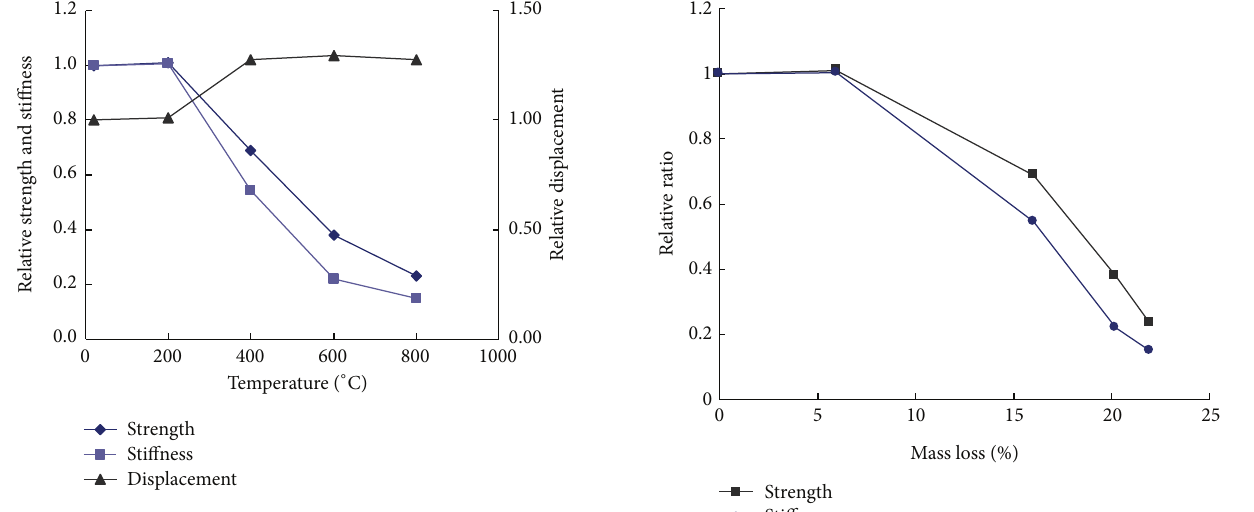
Figure 6: Compressive strength, stiffness, and displacement corre- sponding to peak load with temperatures.